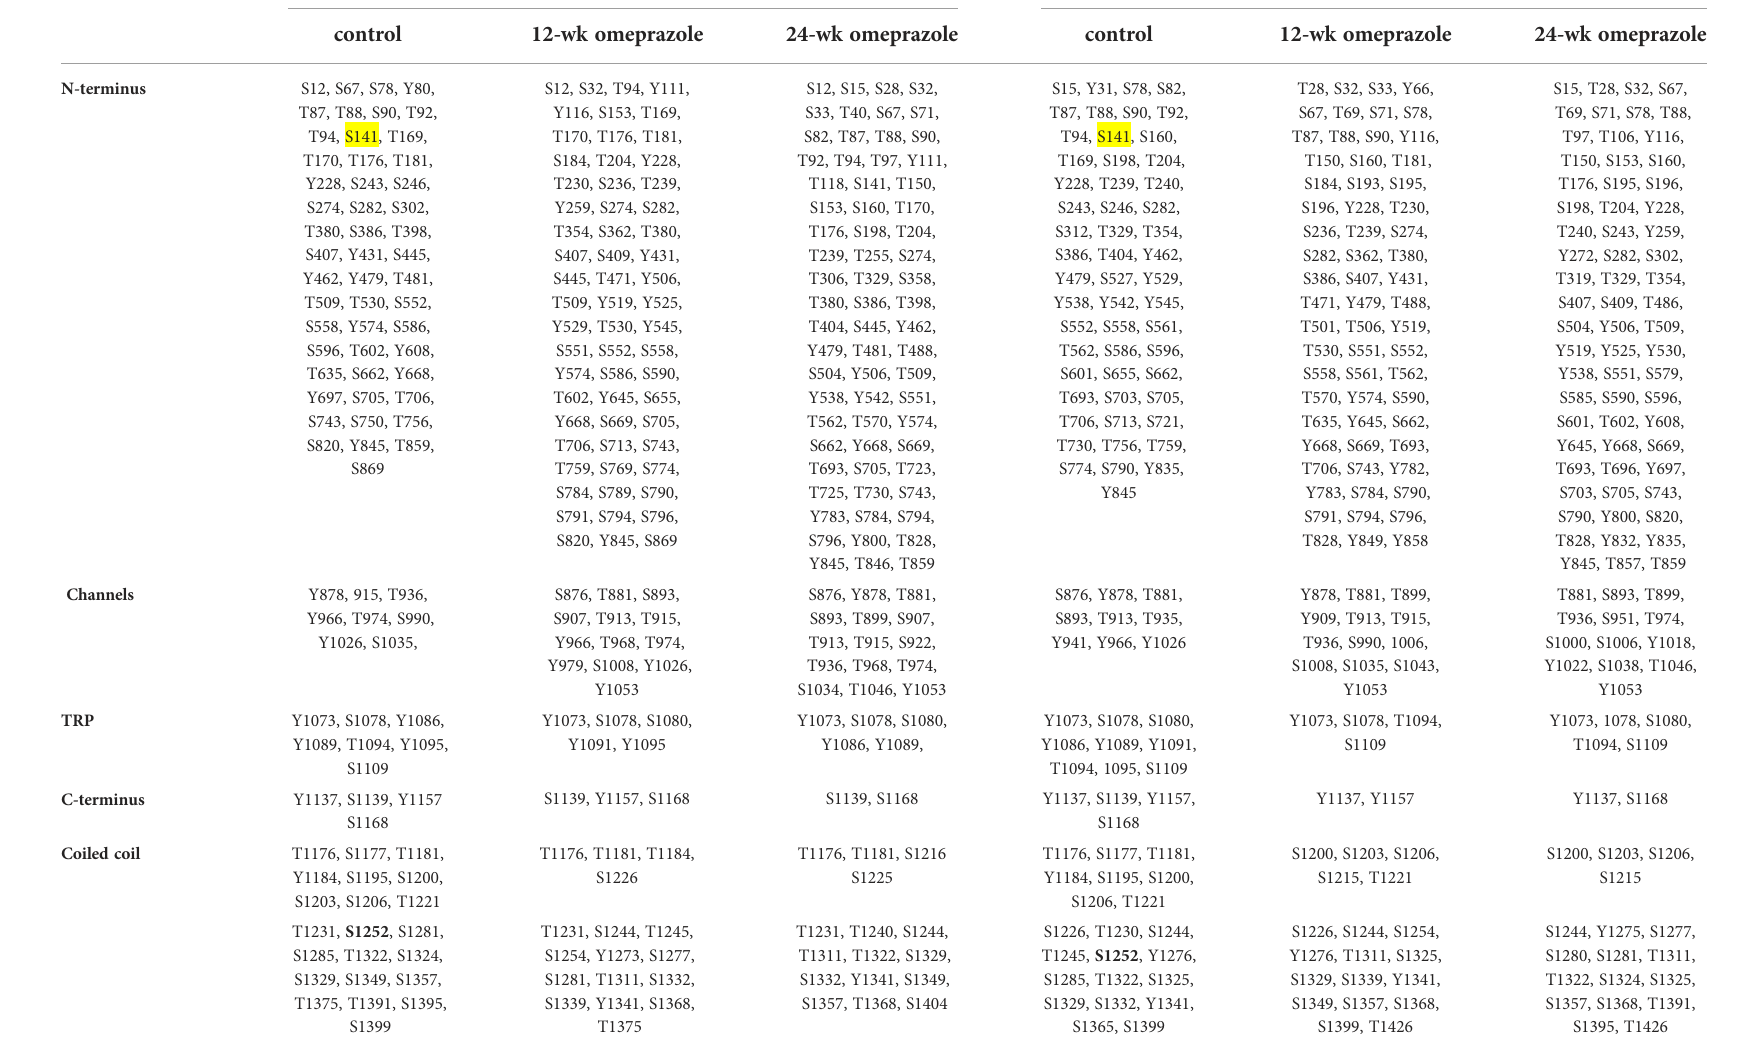
TABLE 1 Phosphorylated residue of TRPM6 protein from duodenum and jejunum of control or omeprazole-treated